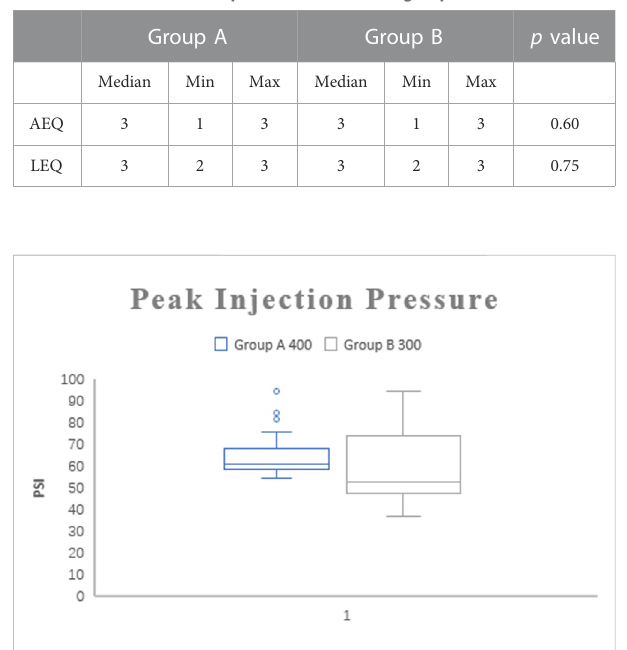
FIGURE 2 Bar graph representing median peak injection pressure between groups.